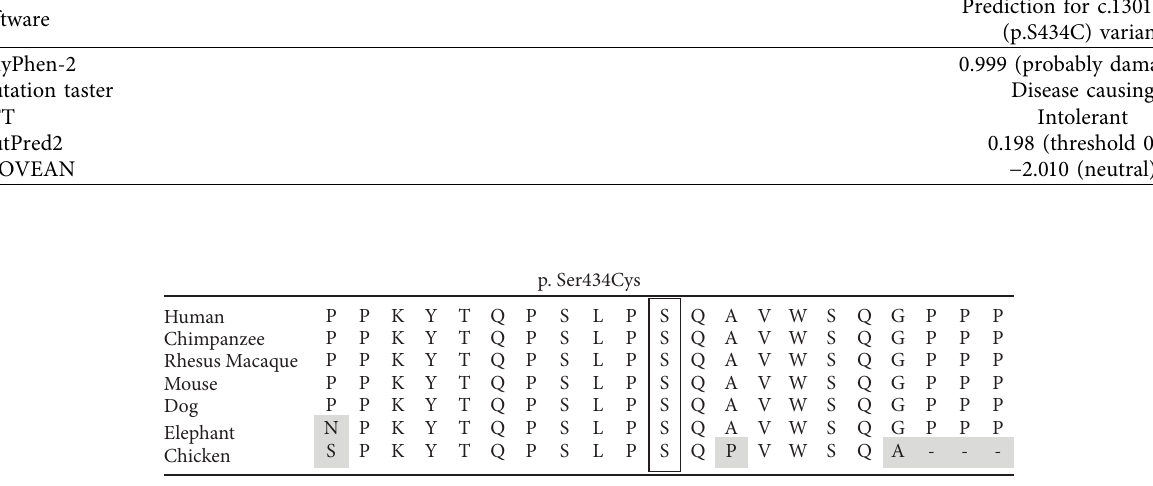
Figure 1: Results of sequence alignment for atrophin-1 surrounding amino acid residue 434 in seven species including Homo sapiens , Pan troglodytes , Macaca mulatta , Mus musculus , Canis lupus familiaris , Loxodonta africana , and Gallus gallus .